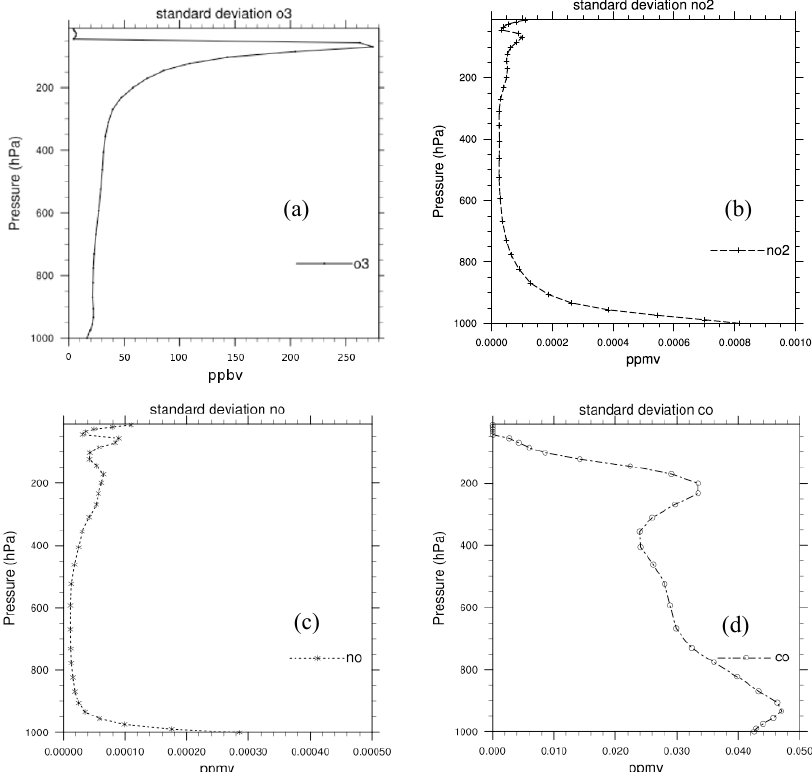
Figure 19. Vertical standard deviation in ppmv of (a) O 3 , (b) NO 2 , (c) NO, and (d) CO (WRF-Chem, res. 36km, D-ensemble).